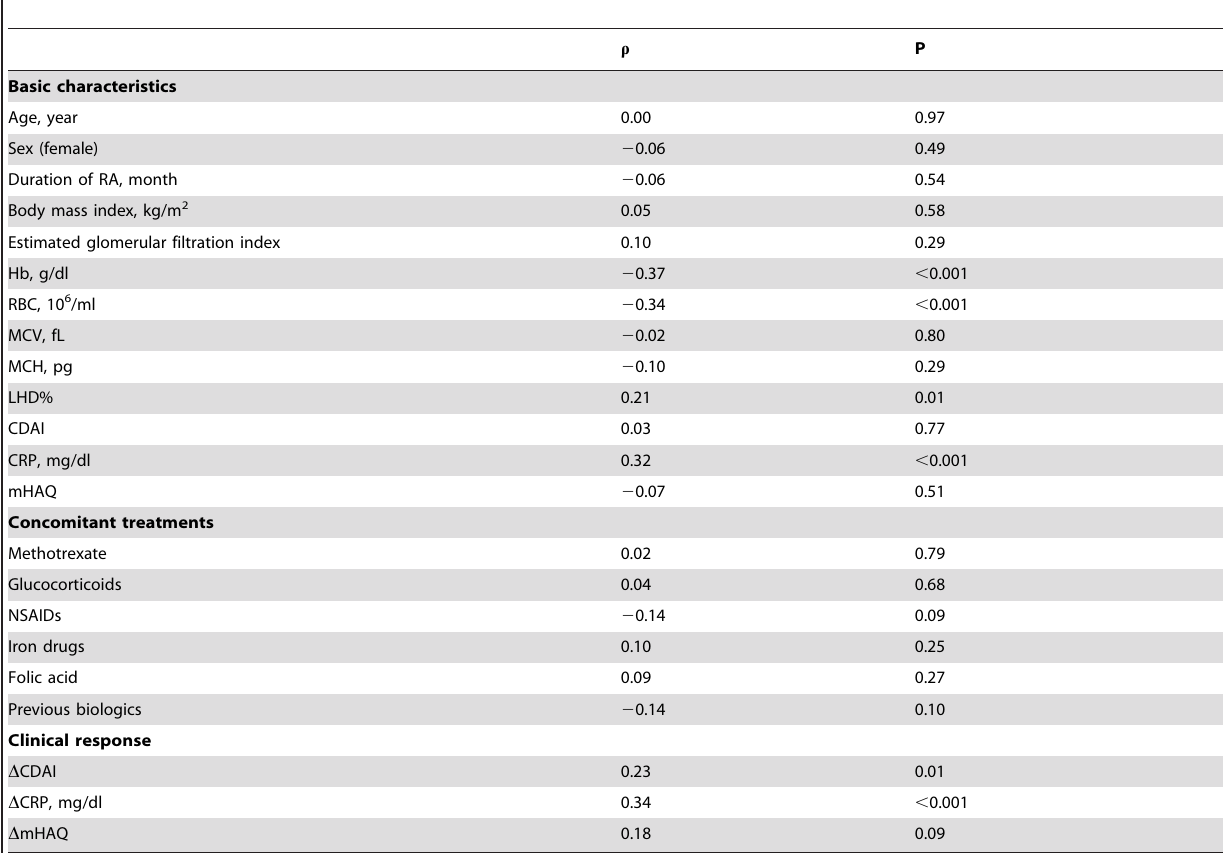
Table 2. Factors associated with increase of Hb levels after biologic therapies.